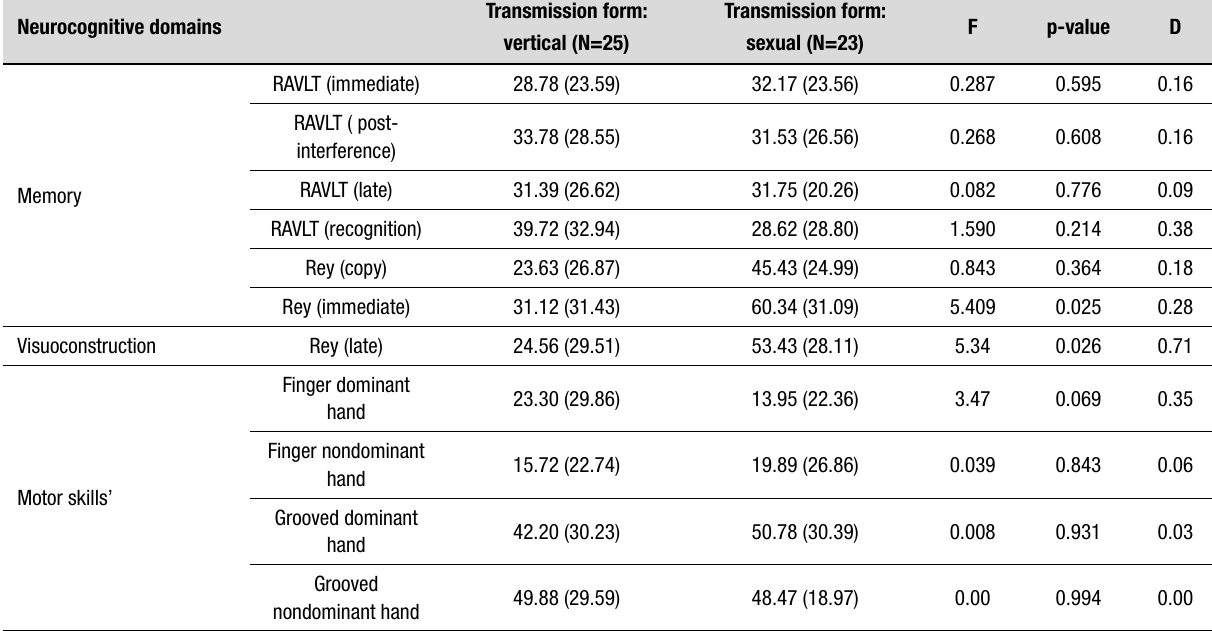
Table 3. Performance in the battery of neuropsychological